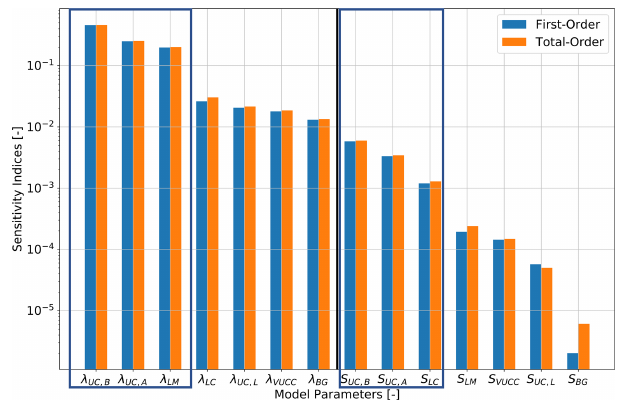
Figure 4. Global sensitivity indices for the analysis combining sed- imentary and crustal layers of the Central European Basin System. The first-order indices are denoted in blue and the total-order in- dices in orange. For the acronyms, please refer to Table